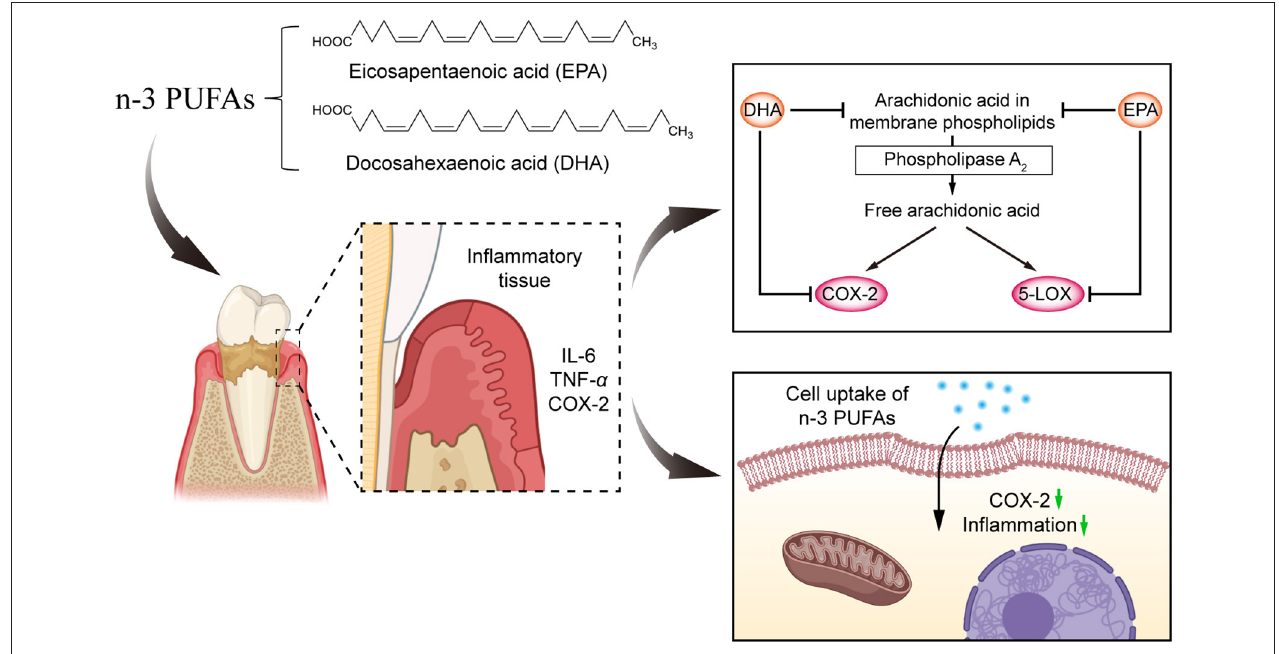
FIGURE 6 | The role of n-3 PUFAs in the reduction of periodontitis.